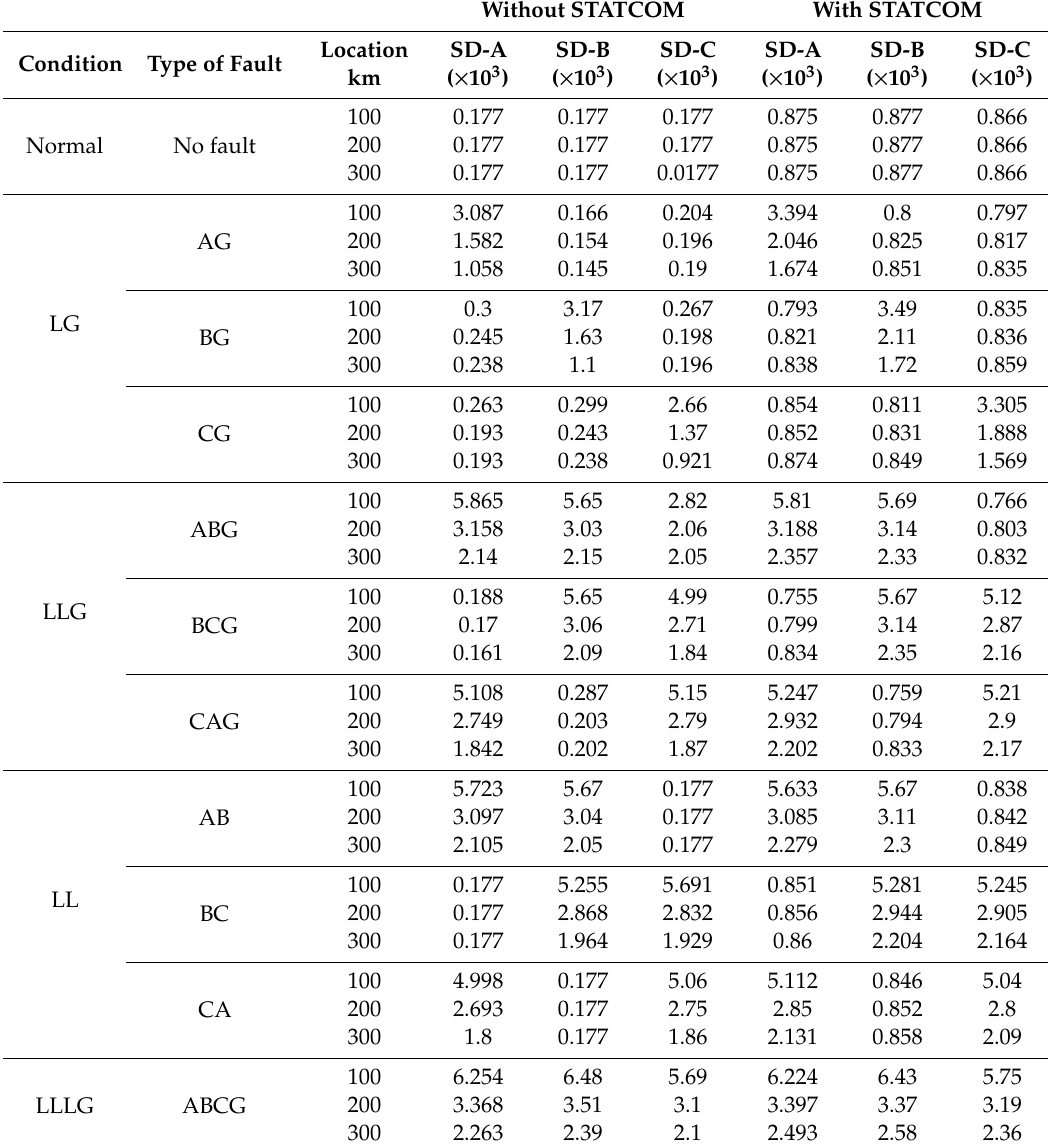
Table 5. Standard deviation (SD)-based feature values for